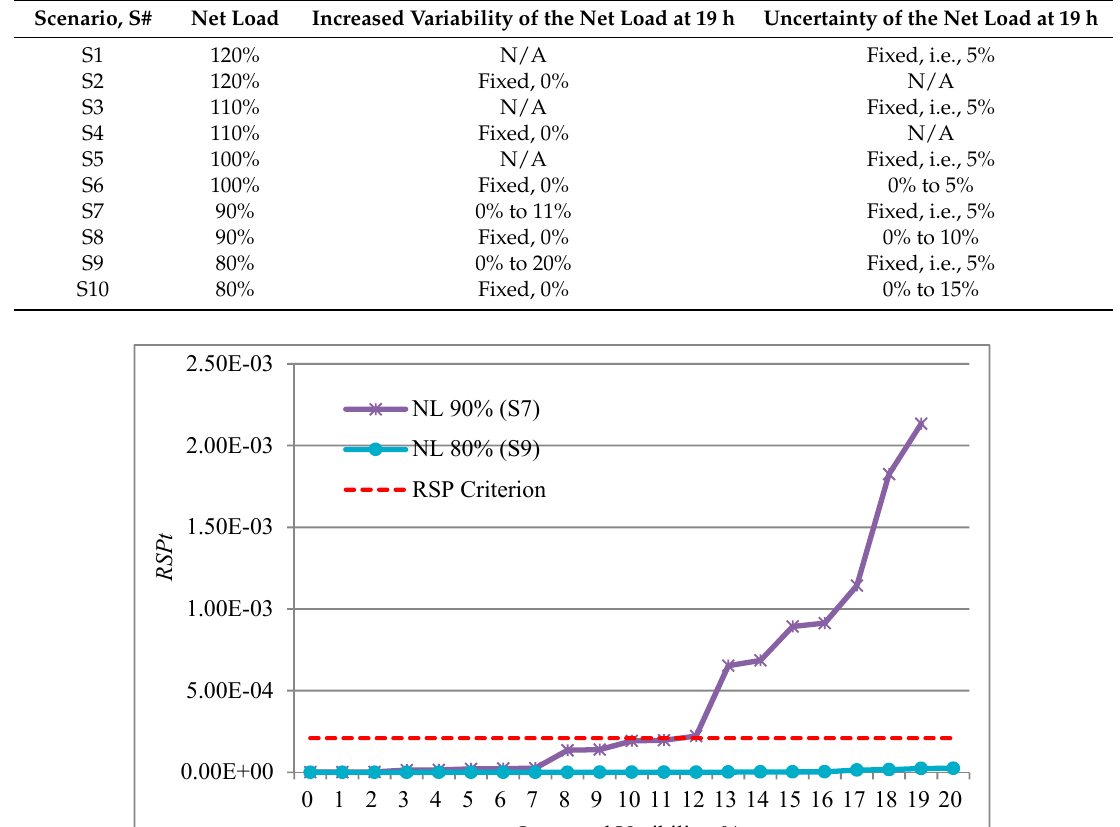
Table 3. Allowed ranges of increased variability and uncertainty. ※ N/A : not allowed.